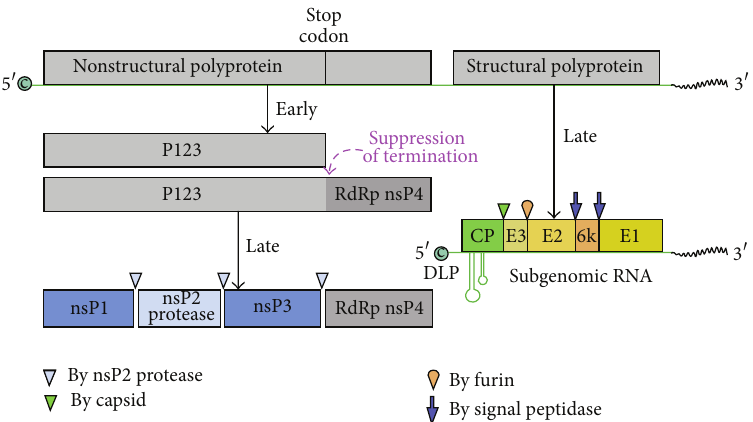
Figure 2: Alphavirus genome organization. Alphaviruses are organized with the (nonstructural) ns proteins at the 5 󸀠 end of the genome The ns proteins are translated from the genomic RNA while the structural proteins are translated from a subgenomic RNA that includes the 3 󸀠 end of the genome. The RNA polymerase nsP4 is a read-through protein present early during infection. After replication is established, protein production switches to the structural proteins C, E3, E2, 6K, and E1. The C protein autoproteolytically cleaves itself from the remaining polyprotein. Only E1, E2, and C are found in the mature virion. In some cases, E3 may also be associated with the virus particles [ Virus DB: VBRC genome browser accession VG0000908 ]